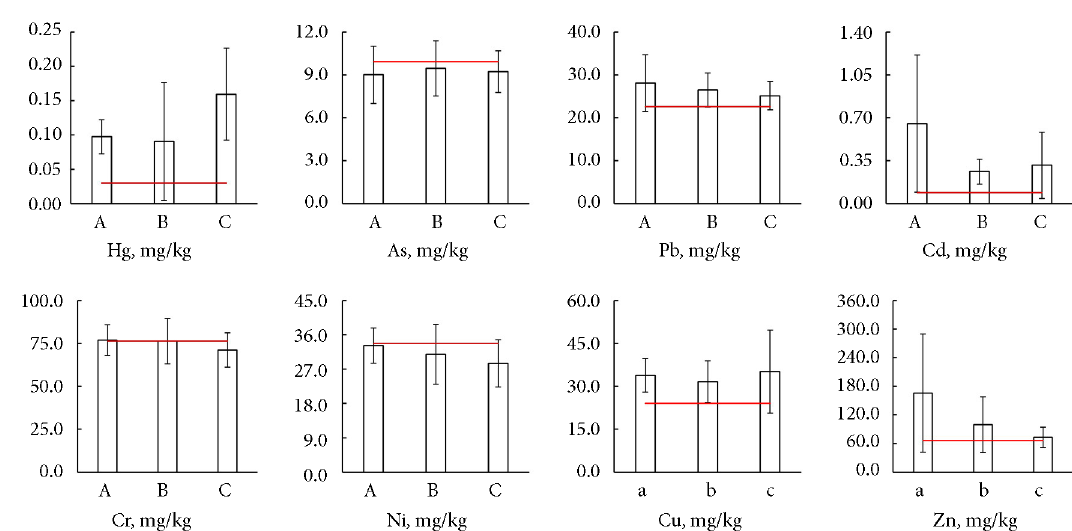
Figure 3. Heavy metal concentrations associated with various types of land reclamation